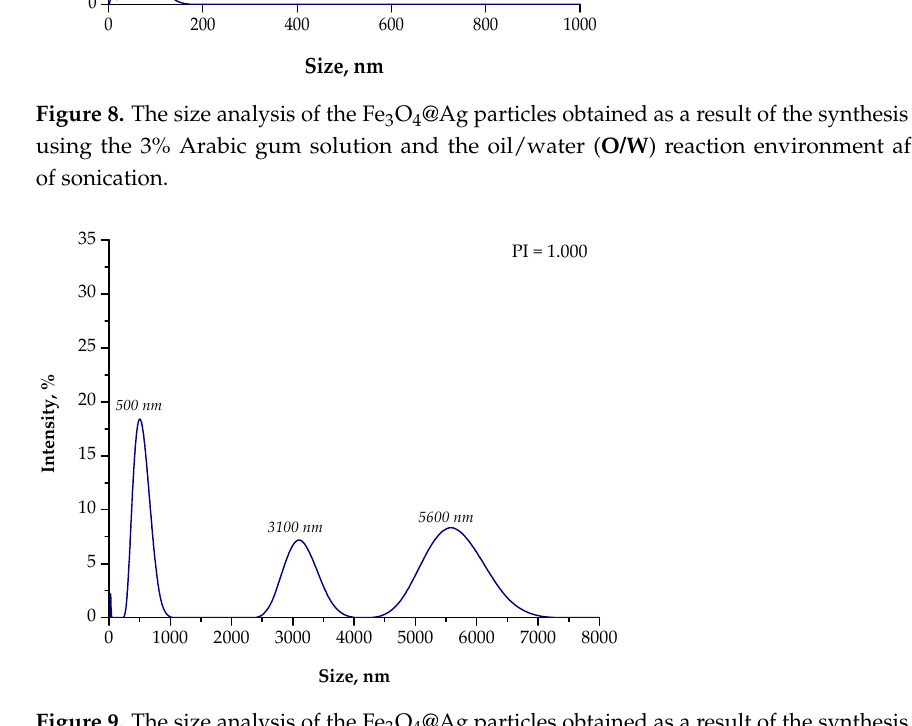
Size, nm 5200 nm Figure 10. The size analysis of the Fe 3 O 4 @Ag particles obtained as a result of the synthesis performed using the 3% Arabic gum solution and the oil ( O ) reaction environment after 15 min of sonication. Based on the DLS analysis, it could be concluded that the introduction of an essential oil into the reaction medium influenced both the particle size distribution and the efficiency of the sonication process. In the case of the reaction performed using the oil/water